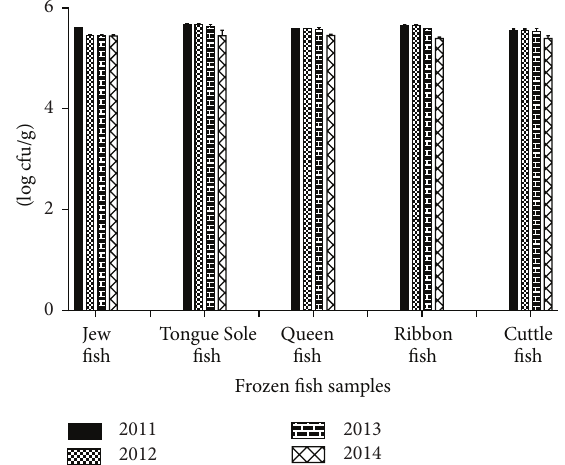
Figure 1: Total viable aerobic count (log cfu/g) of the frozen fish samples. The data were representatives of the three independent experiments using triplicate samples and mean ± SD values were